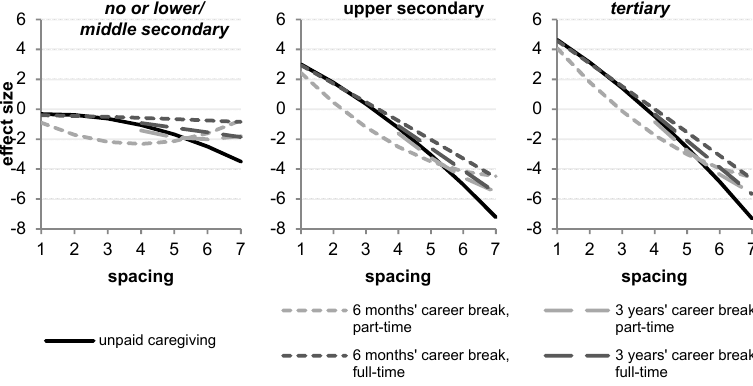
Note : timing constant at seven